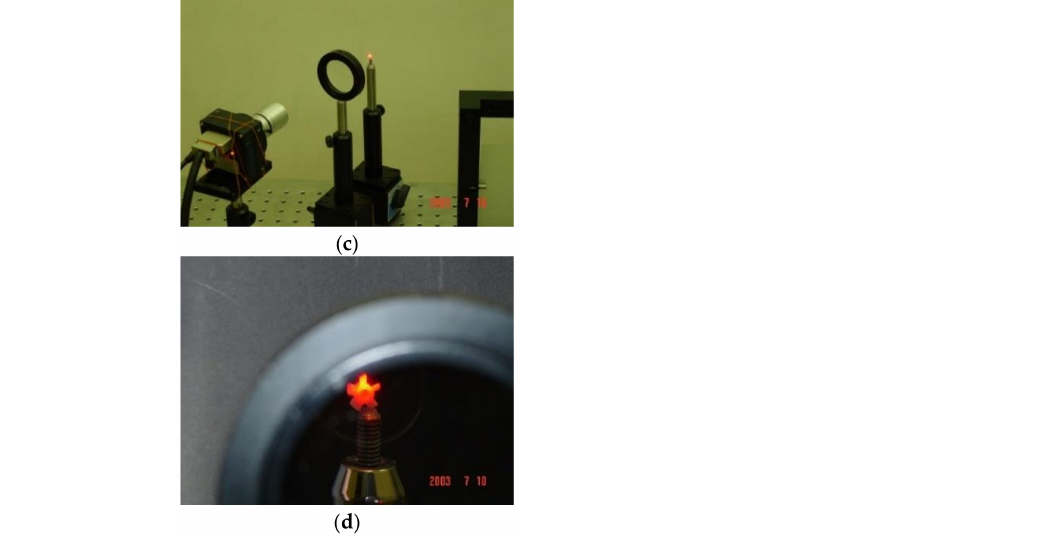
Figure 3. Schematic diagram of Michelson interference and measurement equipment assembly platform. ( a ) Arrangement of measurement equipment. ( b ) Micro-sized part and CCD system. ( c ) Real measurement system and micro-sized part. ( d ) Laser light on the surface of the micro- sized part.